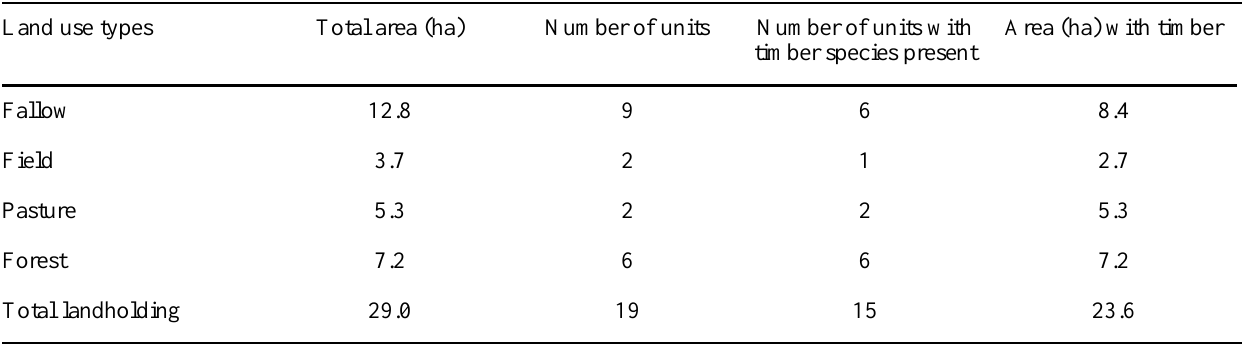
Table 2. Average area and number of land-use types per landholding and presence of timber in smallholder properties in Contamana and Nuevo Piura, Peru, in 2007 ( n =